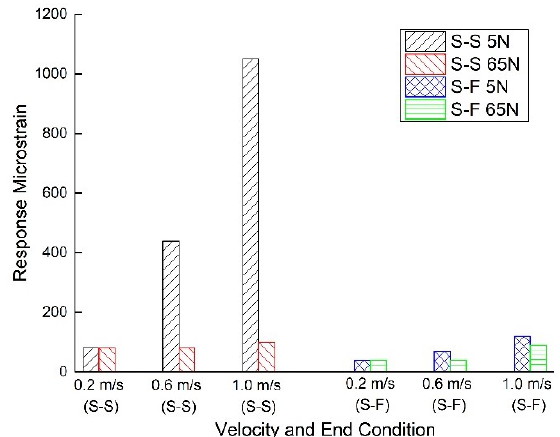
Figure 10. Effects of top tension force on the amplitude of the VIV for UPVC riser.